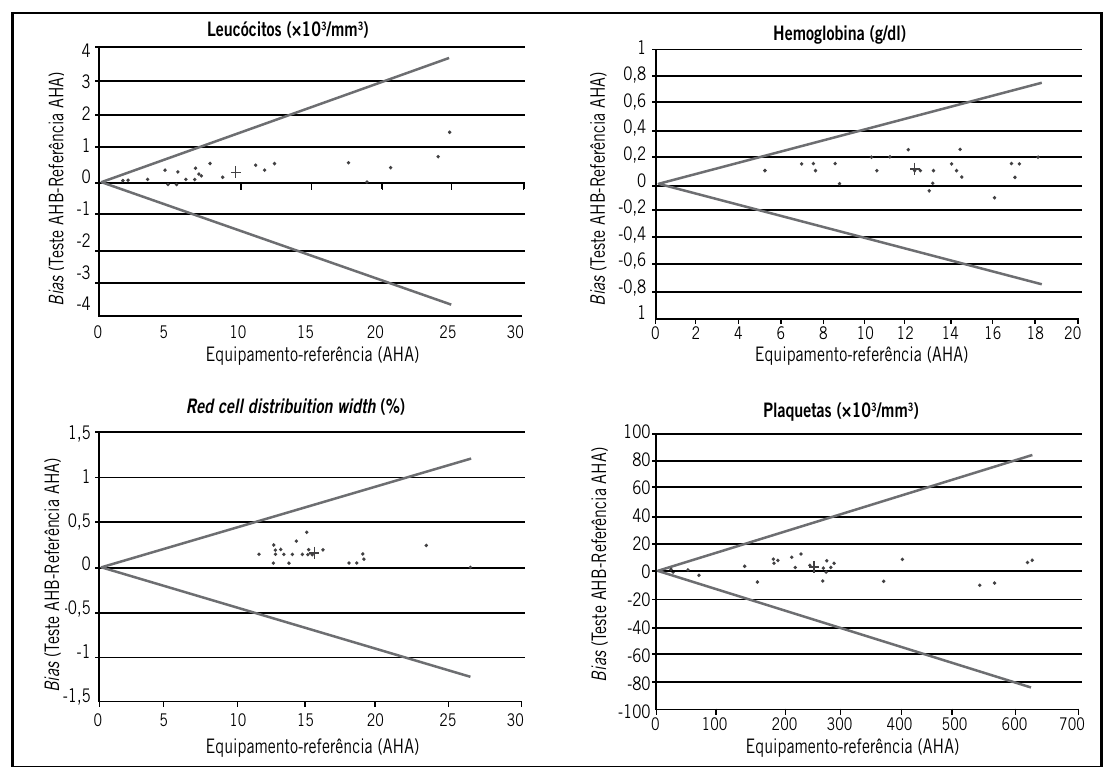
Figura 1 – Diferenças de parâmetros hematológicos entre AHB e AHA A linha < corresponde ao erro total permitido. O símbolo + corresponde ao bias médio.